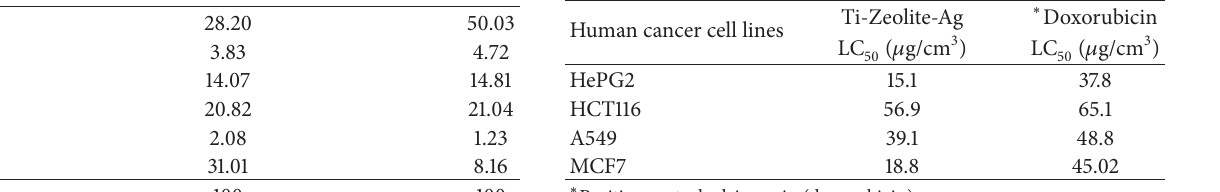
Table 5: EDX microanalysis of the Ag-substituted Ti-Z-A. Element